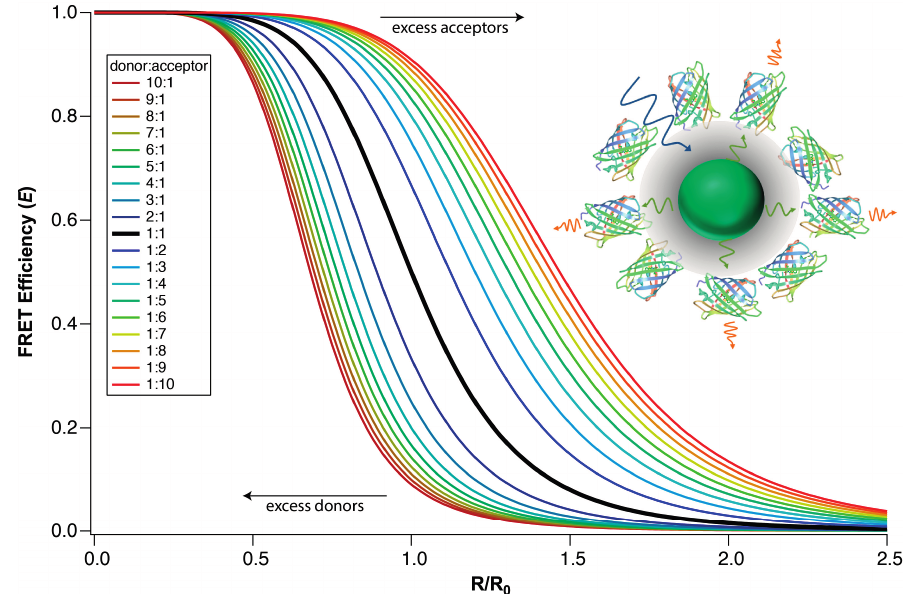
Figure 3. The distance dependence of FRET efficiency for multivalent systems. The FRET efficiency at a given distance improves as the number of acceptors per donor, n , increases, and vice versa . The inset shows an example of a multivalent system: multiple fluorescent protein acceptors are bound to a single QD donor. Inset reprinted with permission from [47]. Copyright (2012) American Chemical